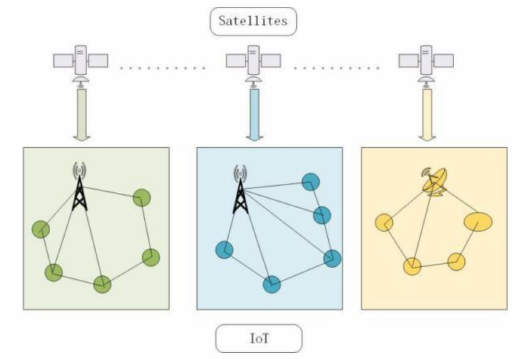
Figure 4. A network model for satellite-based